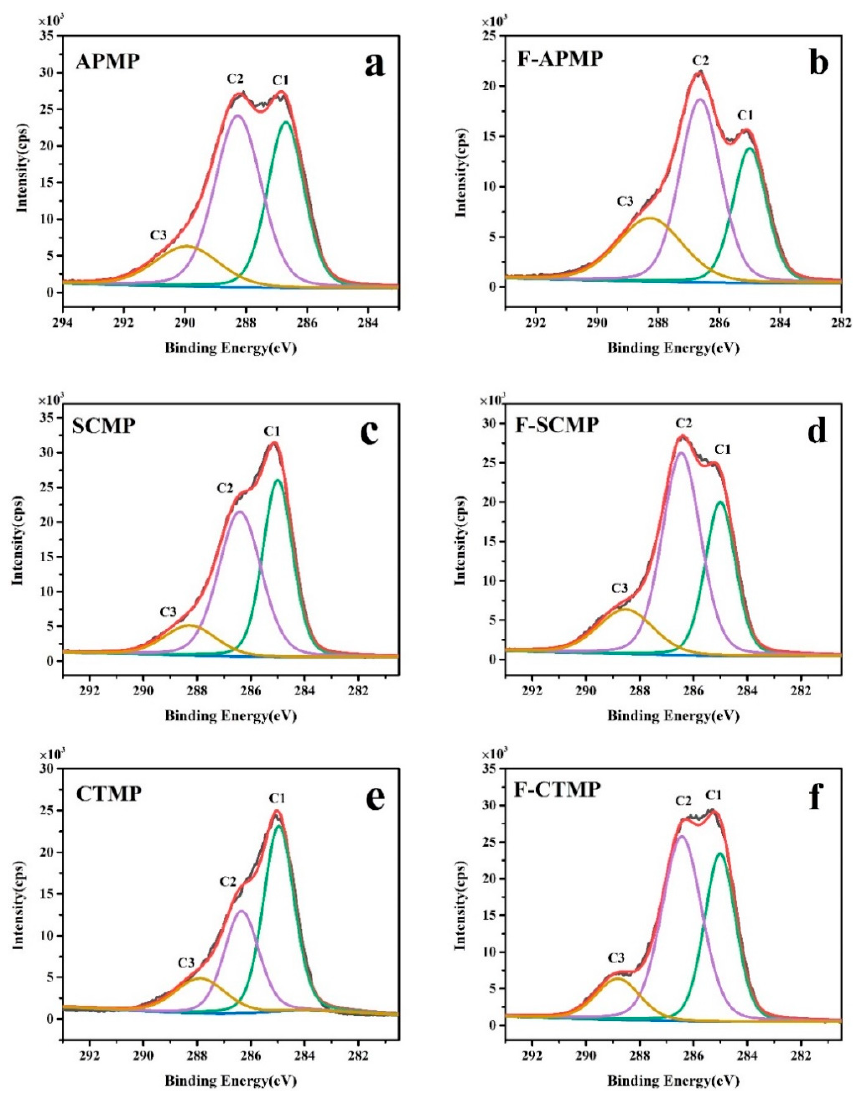
Figure 6. XPS analysis of the C1s peak of the pulp: ( a ) APMP; ( b ) F-APMP; ( c ) SCMP; ( d ) F-SCMP; ( e ) CTMP; and ( f ) F-CTMP.